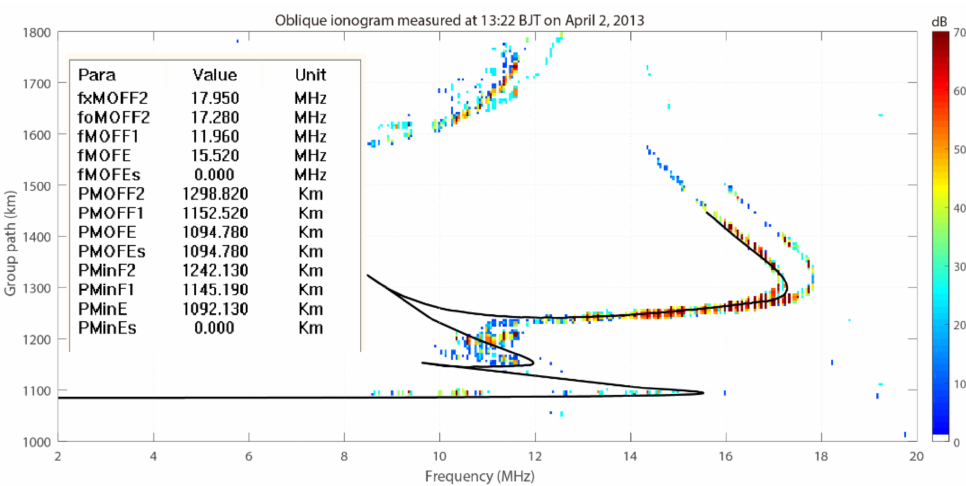
Figure 8. Similar to Figure 6, but oblique ionogram was measured at 13:22 BJT on 2 April 2013 without the Es layer. Oblique ionograms measured during 8–16 April 2013 by the ionosondes between Wuhan and Beijing stations were used to carry out statistical analysis of the performance of the proposed method. The ground distance between Wuhan and Beijing stations is approximately 1040 km. The number of measured oblique ionograms is about